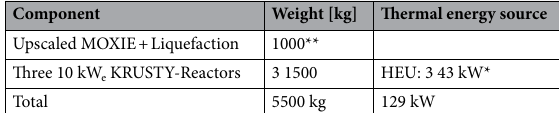
Table 13. Estimation of the weight of the MOXIE system components and the thermal performance. * 55 . ** 57 .